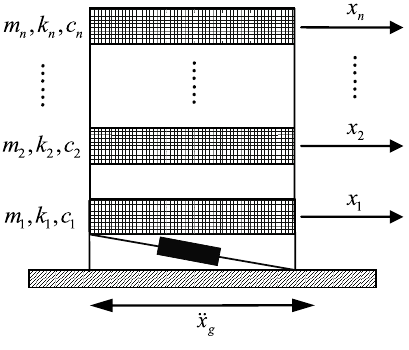
Fig. 1. n -story building model with